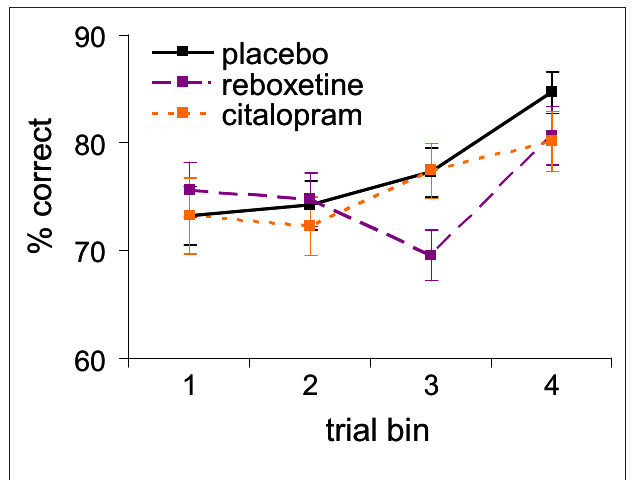
Figure S1 | Learning curves illustrating the change in tone- discrimination performance over the four consecutive trial bins in the diminishing-utility task, separately for each treatment group (error bars indicate standard errors of the mean).